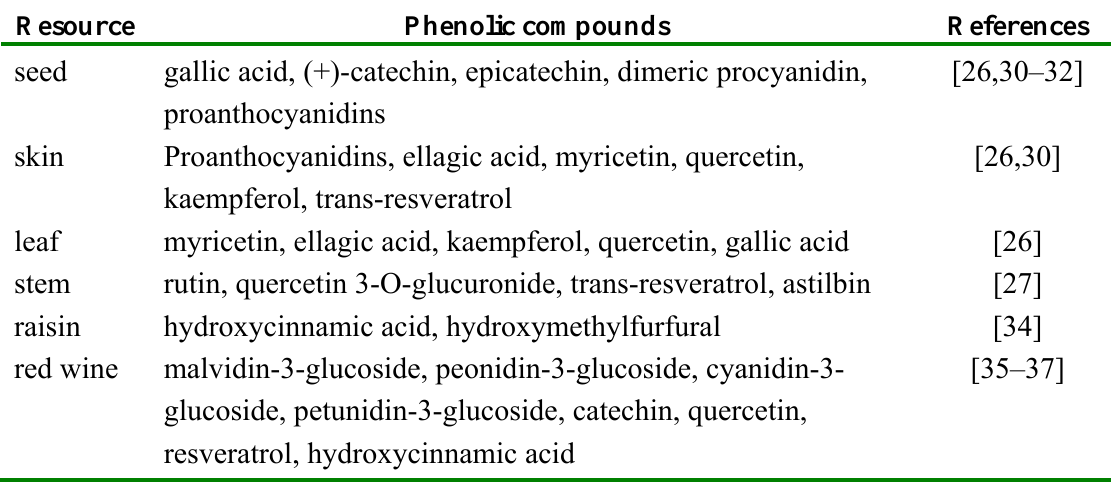
Table 1. The phenolic compounds in different parts of grape and its products.